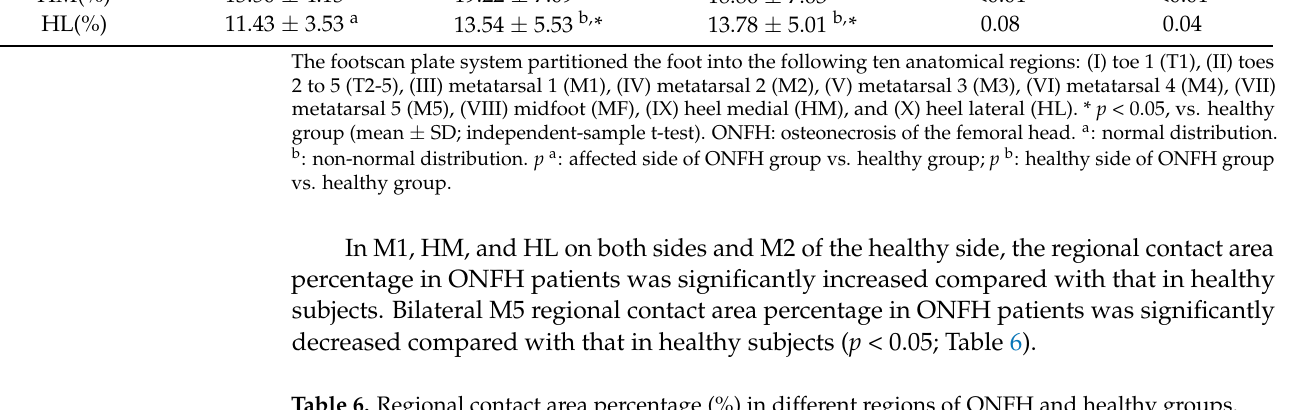
Table 6. Regional contact area percentage (%) in different regions of ONFH and healthy